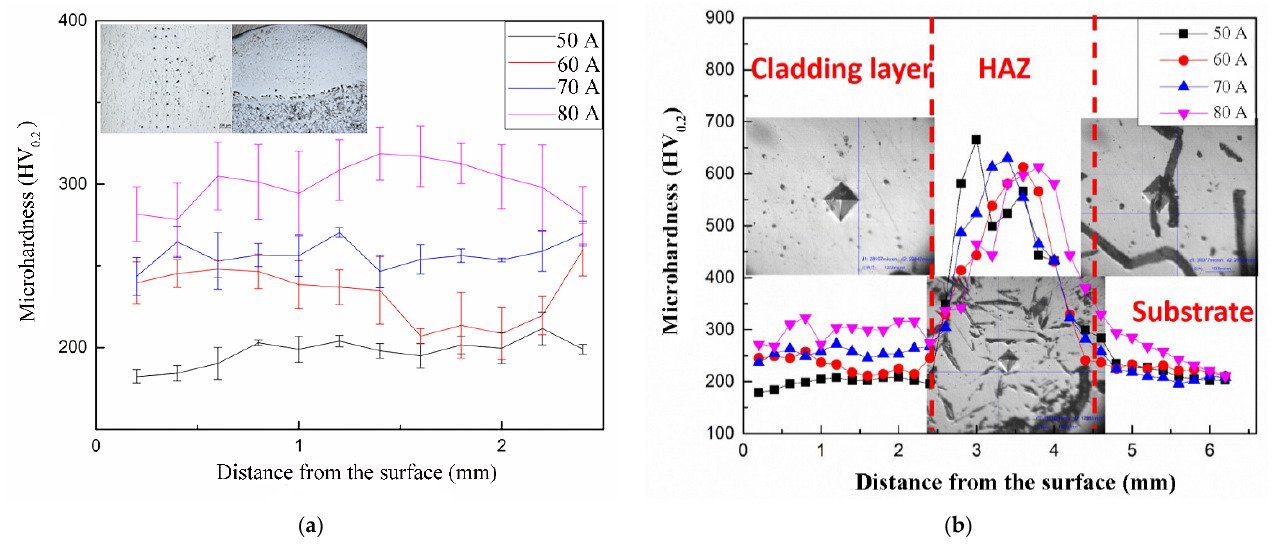
Figure 8. Microhardness of CoCrFeNiMn HEA coatings: ( a ) microhardness distribution along the top surface to the substrate across the cross-section of the HEA coatings, ( b ) microhardness distribution along the top surface to the substrate. Table 6. Grain width of dendritic structure at different plasma currents.